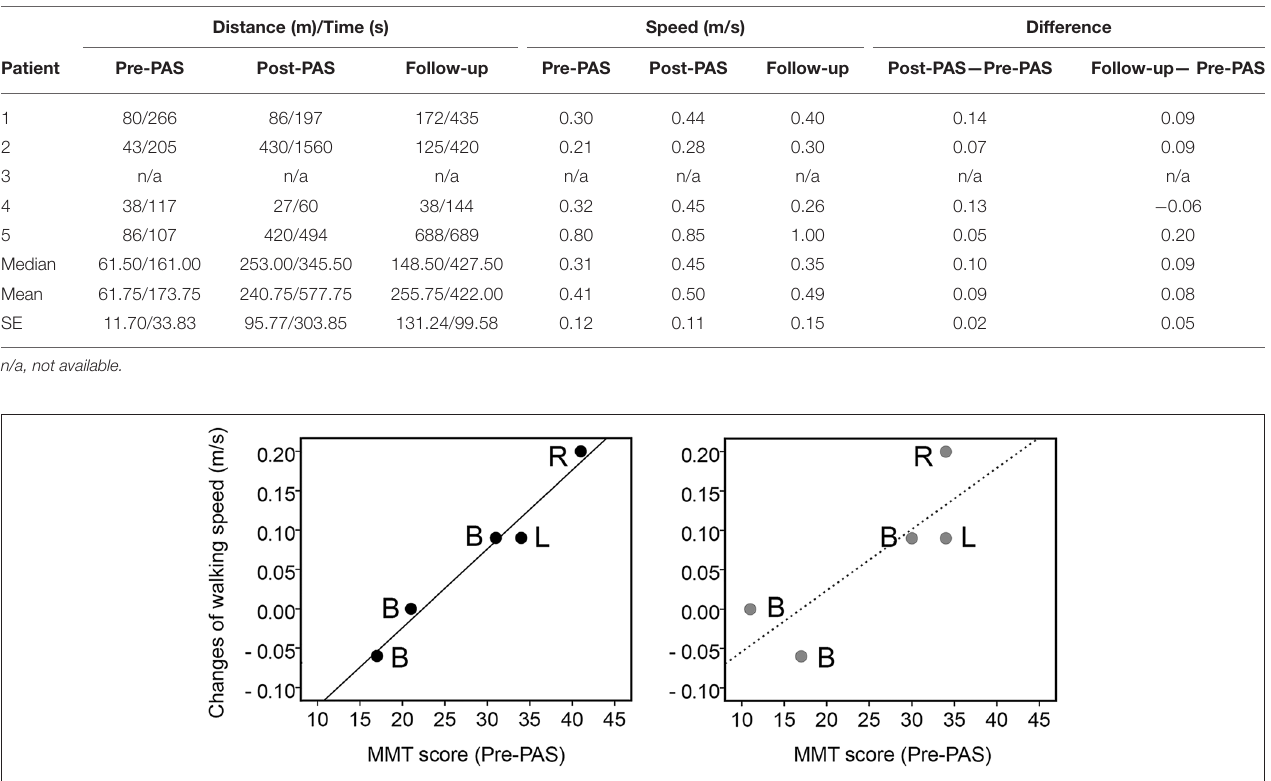
FIGURE 3 | Relationship between the sum of the MMT scores collected in stimulated lower limbs prior the intervention (Pre-PAS) from the key muscles (left) and remaining muscles (right) and changes in walking speed obtained during follow-up. Linear regression—solid and dashed lines. R—only right leg was stimulated, L—only left leg was stimulated, B—both legs were